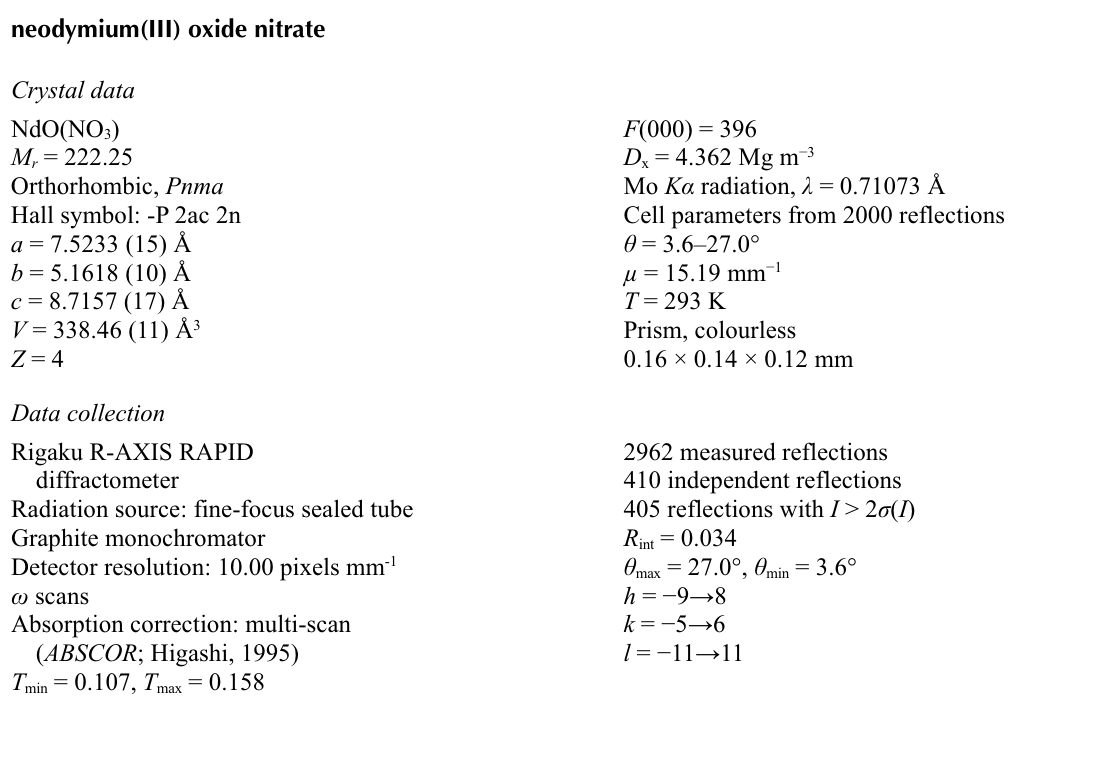
A packing diagram for (I), viewed along